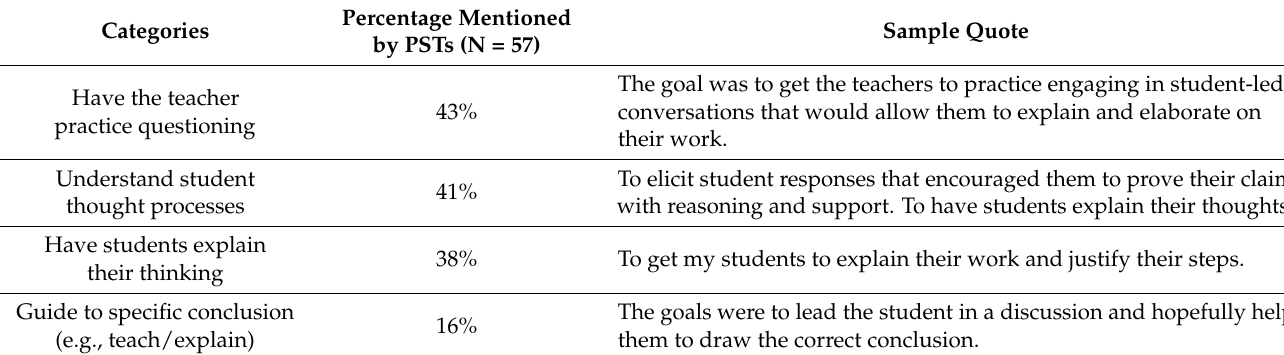
Table 8. PSTs’ perceptions of the goals of ELK from open-ended survey